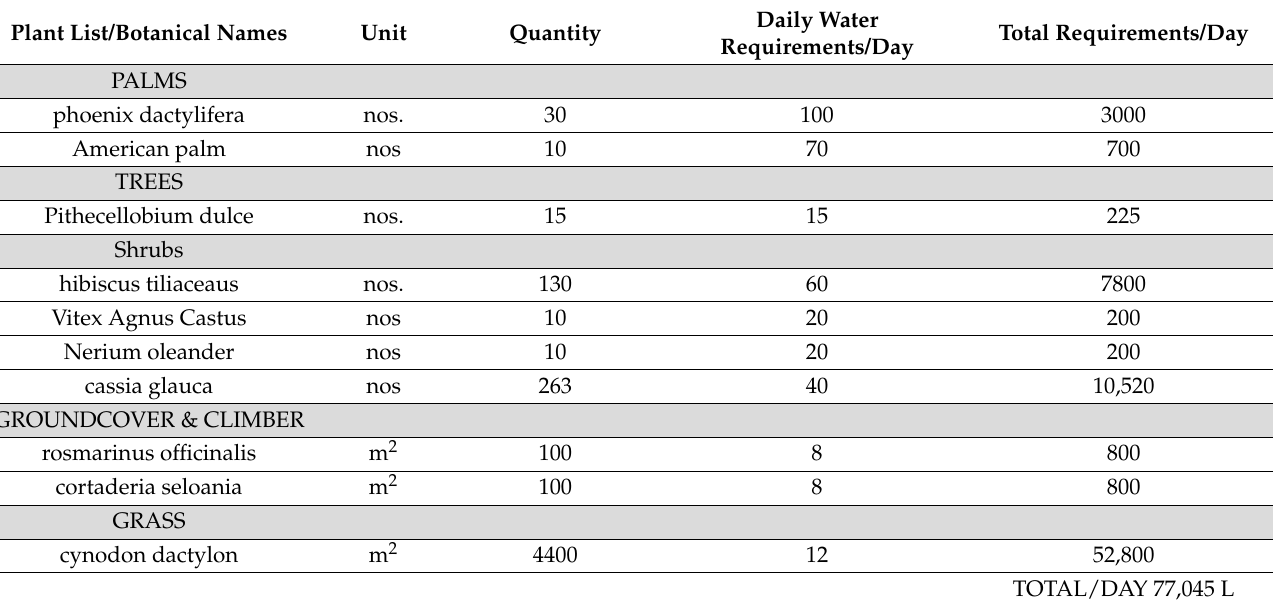
Table A3. Water consumption for each softscape item: previous situation for GATE 11 landscape area.